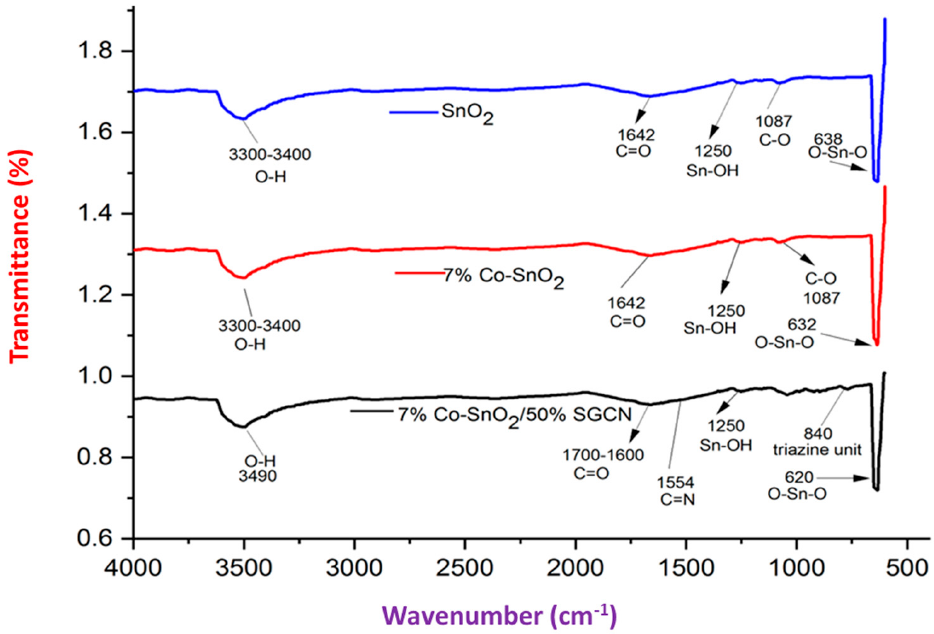
Figure 4. FTIR spectra of SnO 2 , 7% Co-SnO 2 and 7% Co-SnO 2 /50% SGCN.